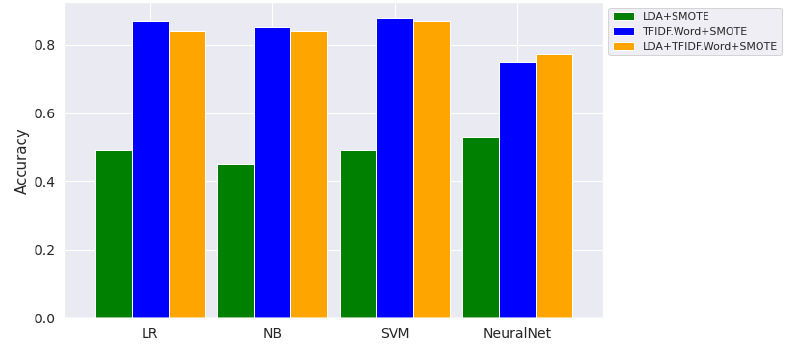
Figure 3. Effects of Features on Performance of Topic